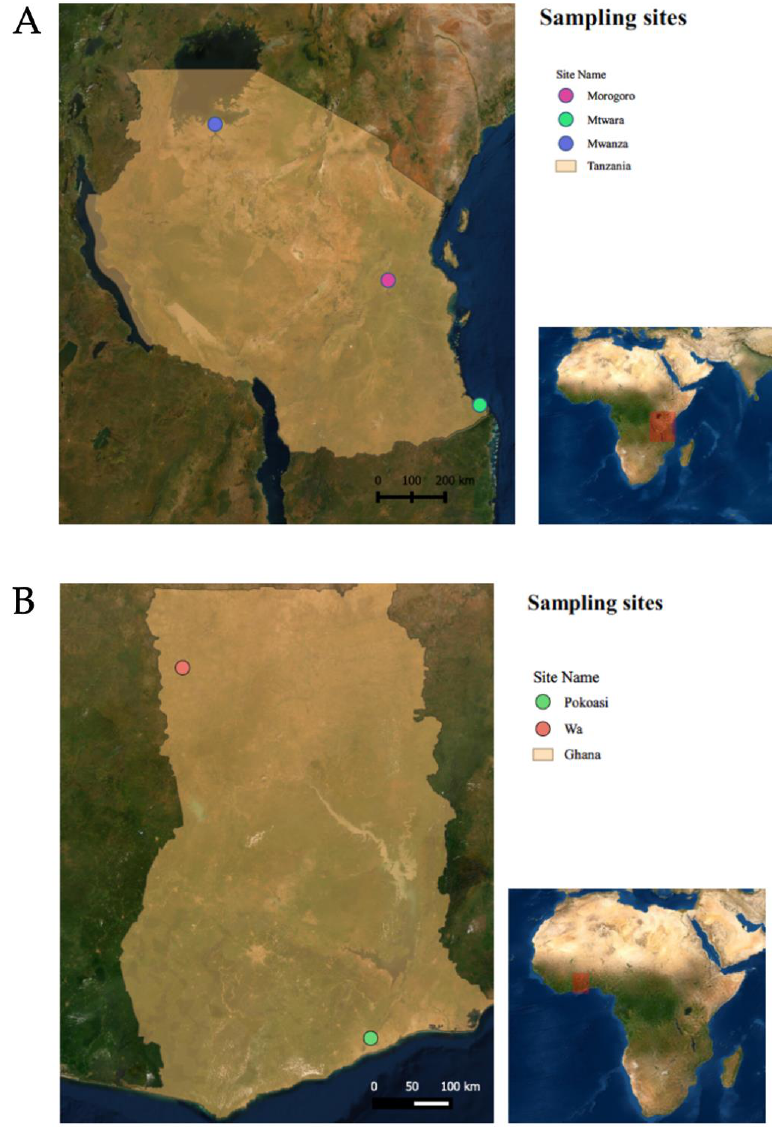
Figure 1. Sample sites for ( A ) Tanzania (Morogoro, Mtwara and Mwanza) and ( B ) Ghana (Pokoasi and Wa).